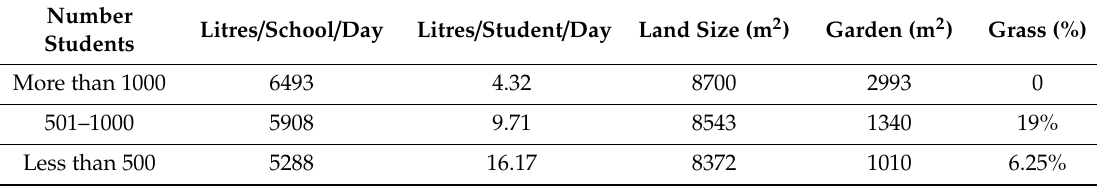
Table 3. Average daily water consumption according to the number of students and land area (m 2 )